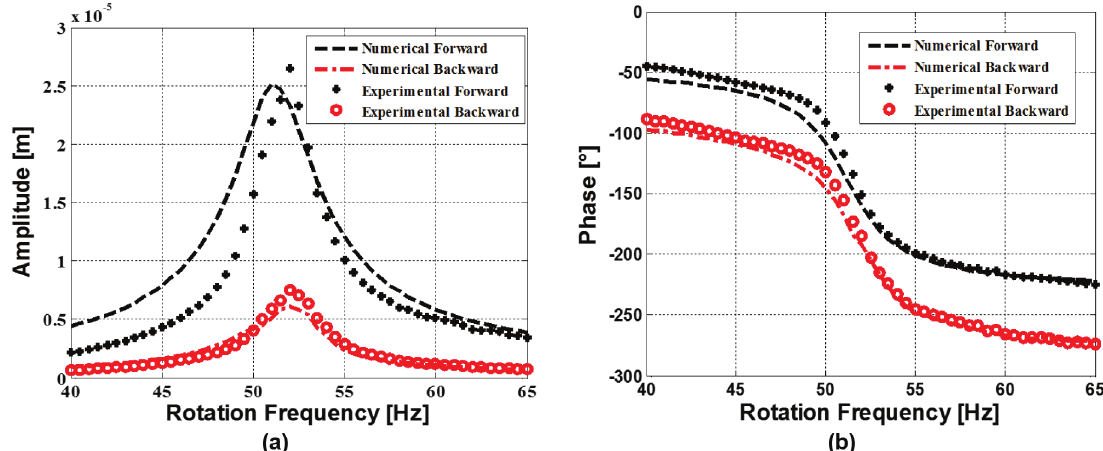
Figure 17 - Directional response of the system (bearing B2 position) for Case 2 – a) Amplitude and b)